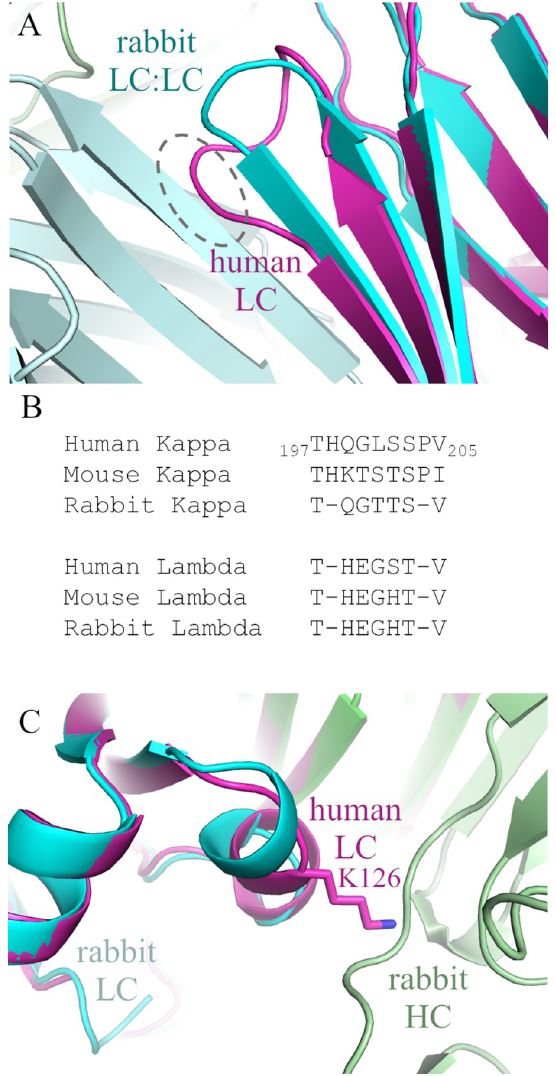
Fig 2. Incompatibility of human kappa constant FG loop with rabbit like LC:LC packing. (A) Structural alignment of the human fab from 4NZU.pdb (magenta) [14] on the rabbit Fab crystal packing from 4ZTO (cyan and pale cyan) shows that the rabbit Constant Kappa FG loop (cyan) is much more compact and compatible with the beta sheet packing and that the longer and bulging human loop (magenta in dashed grey circle) would not be. (B) Sequence alignment of FG loops of human, mouse and rabbit kappa constant domains and lambda constant domains. Rabbit loops are two residues shorter and lack a proline. They resemble the FG loop from the lambda constant domains. (C) Second potential site of interference is the human K126 sidechain. Alignment shows that it could interfere with HC: HC packing.